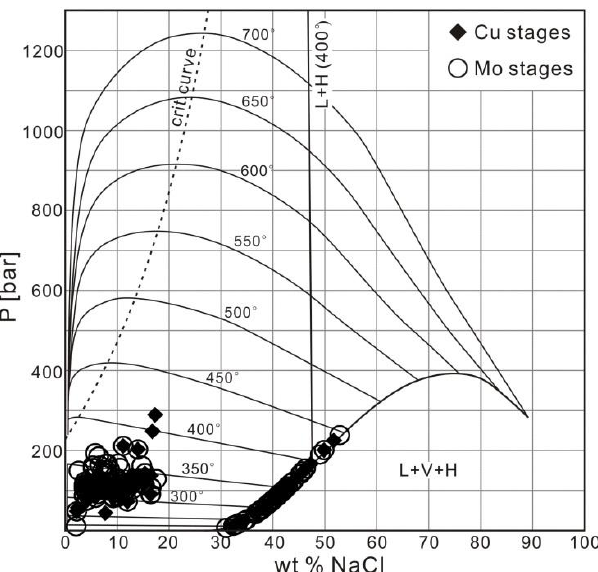
Figure 10. NaCl–H 2 O P–T–X phase diagram [47]. The liquid + vapor coexistence surface is projected onto the P–X plane and contoured for temperature. The limit of liquid + halite coexistence at 400 °C is also shown.